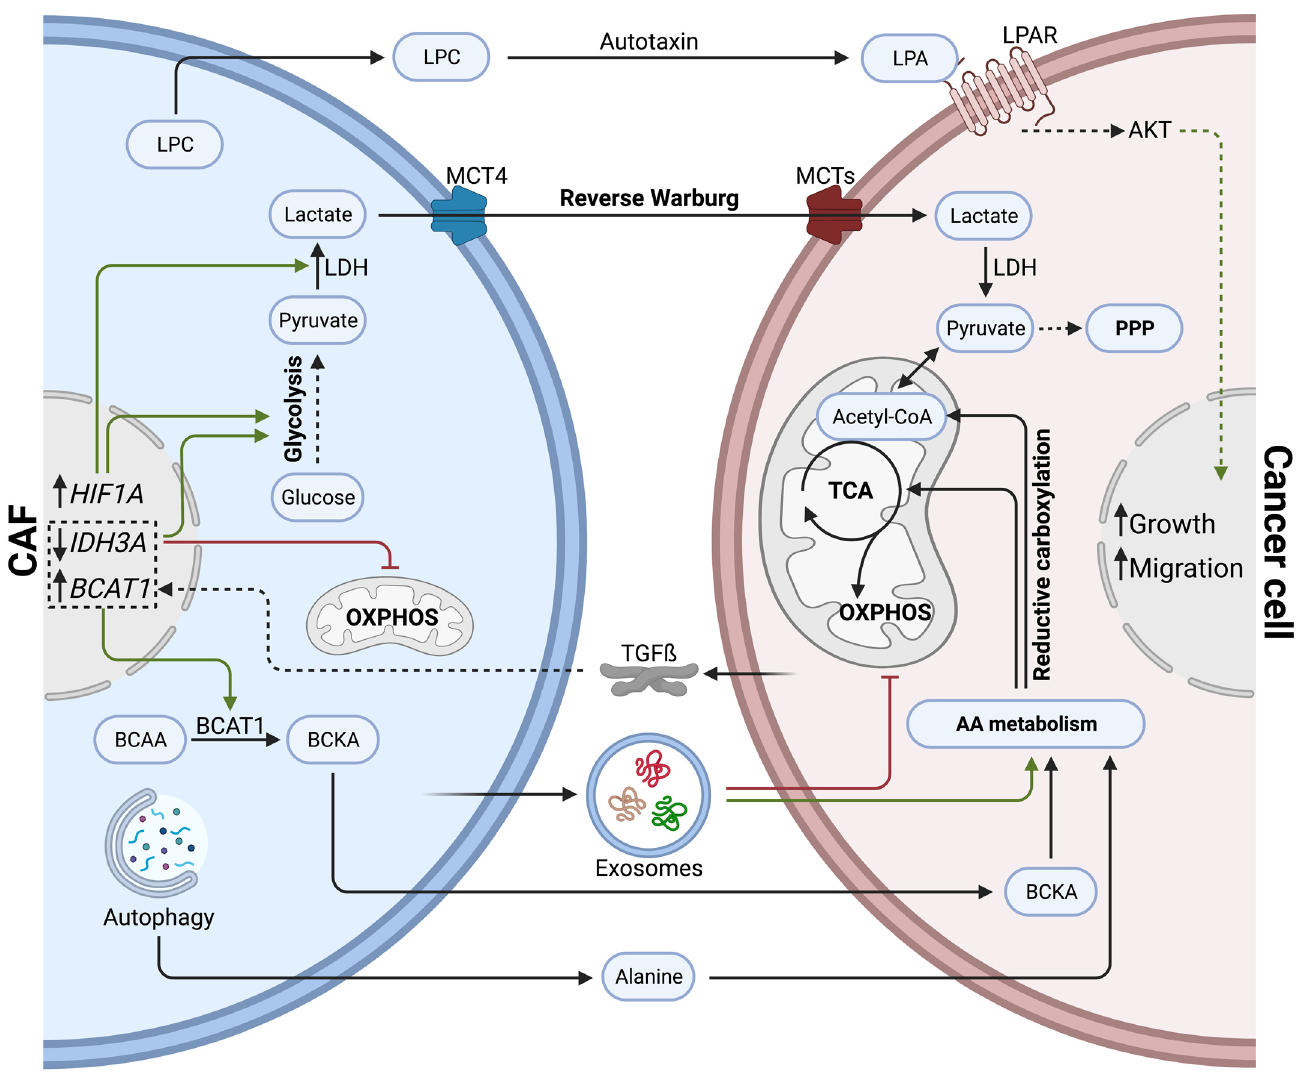
Figure 2. Direct effects of cancer-associated fibroblasts on cancer cell metabolism via metabolite exchange in PDAC. CAFs influence cancer cell metabolism by secreting lactate (reverse Warburg effect), amino acids, lipids, and exosomes. Cancer cells shift towards amino acid metabolism, TCA cycle, and pentose phosphate pathways to support anabolic processes and growth.